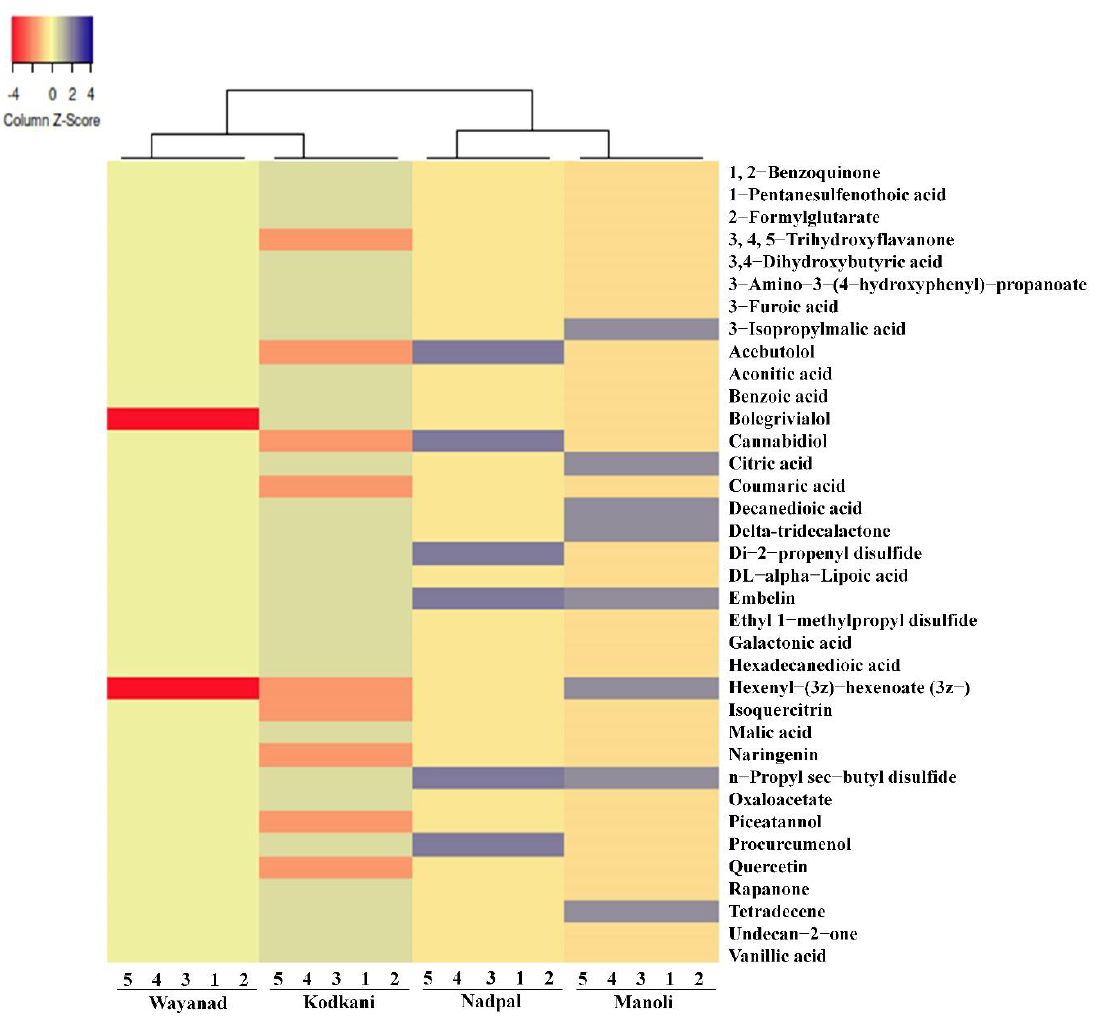
Figure 2. The distribution of identified metabolites across the accessions. The accessions showed a variation in the distribution of metabolites across the accessions. The color scheme at the top left corner codes for the Z-scores ( − 4 to +4) calculated over binary co-ordinates of the samples. The dendrogram at the top of the heatmap indicates the average linkage clustering computed between samples based on the Manhattan distance.